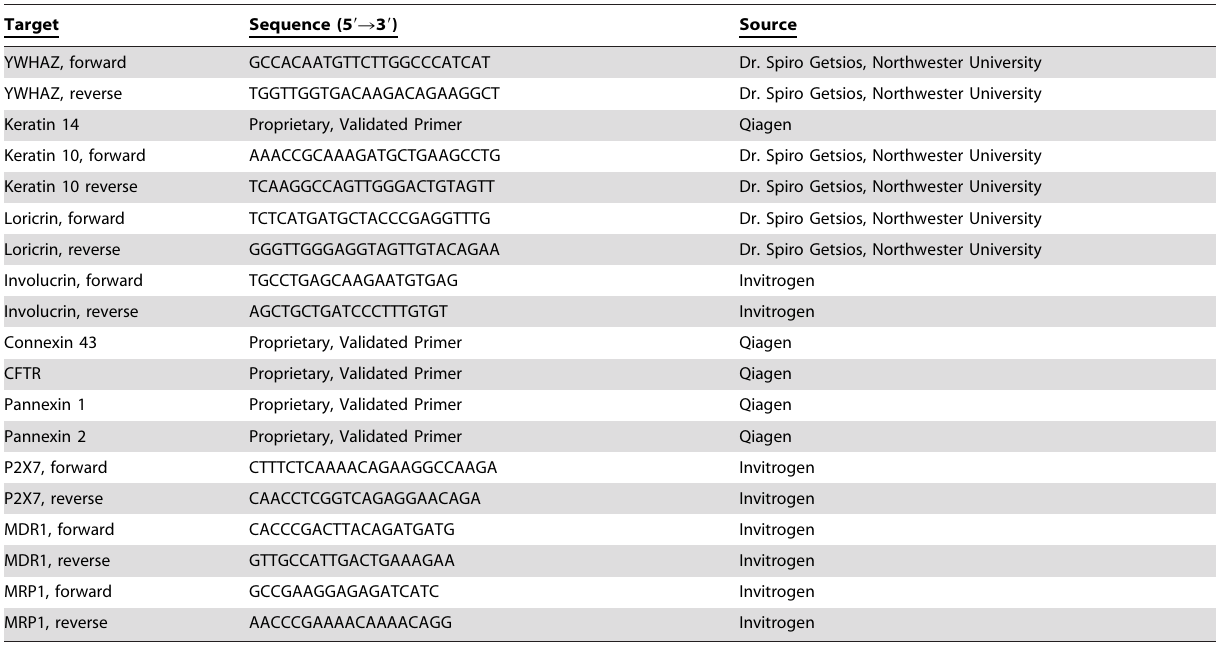
Table 1. Primers used for qPCR analyses.